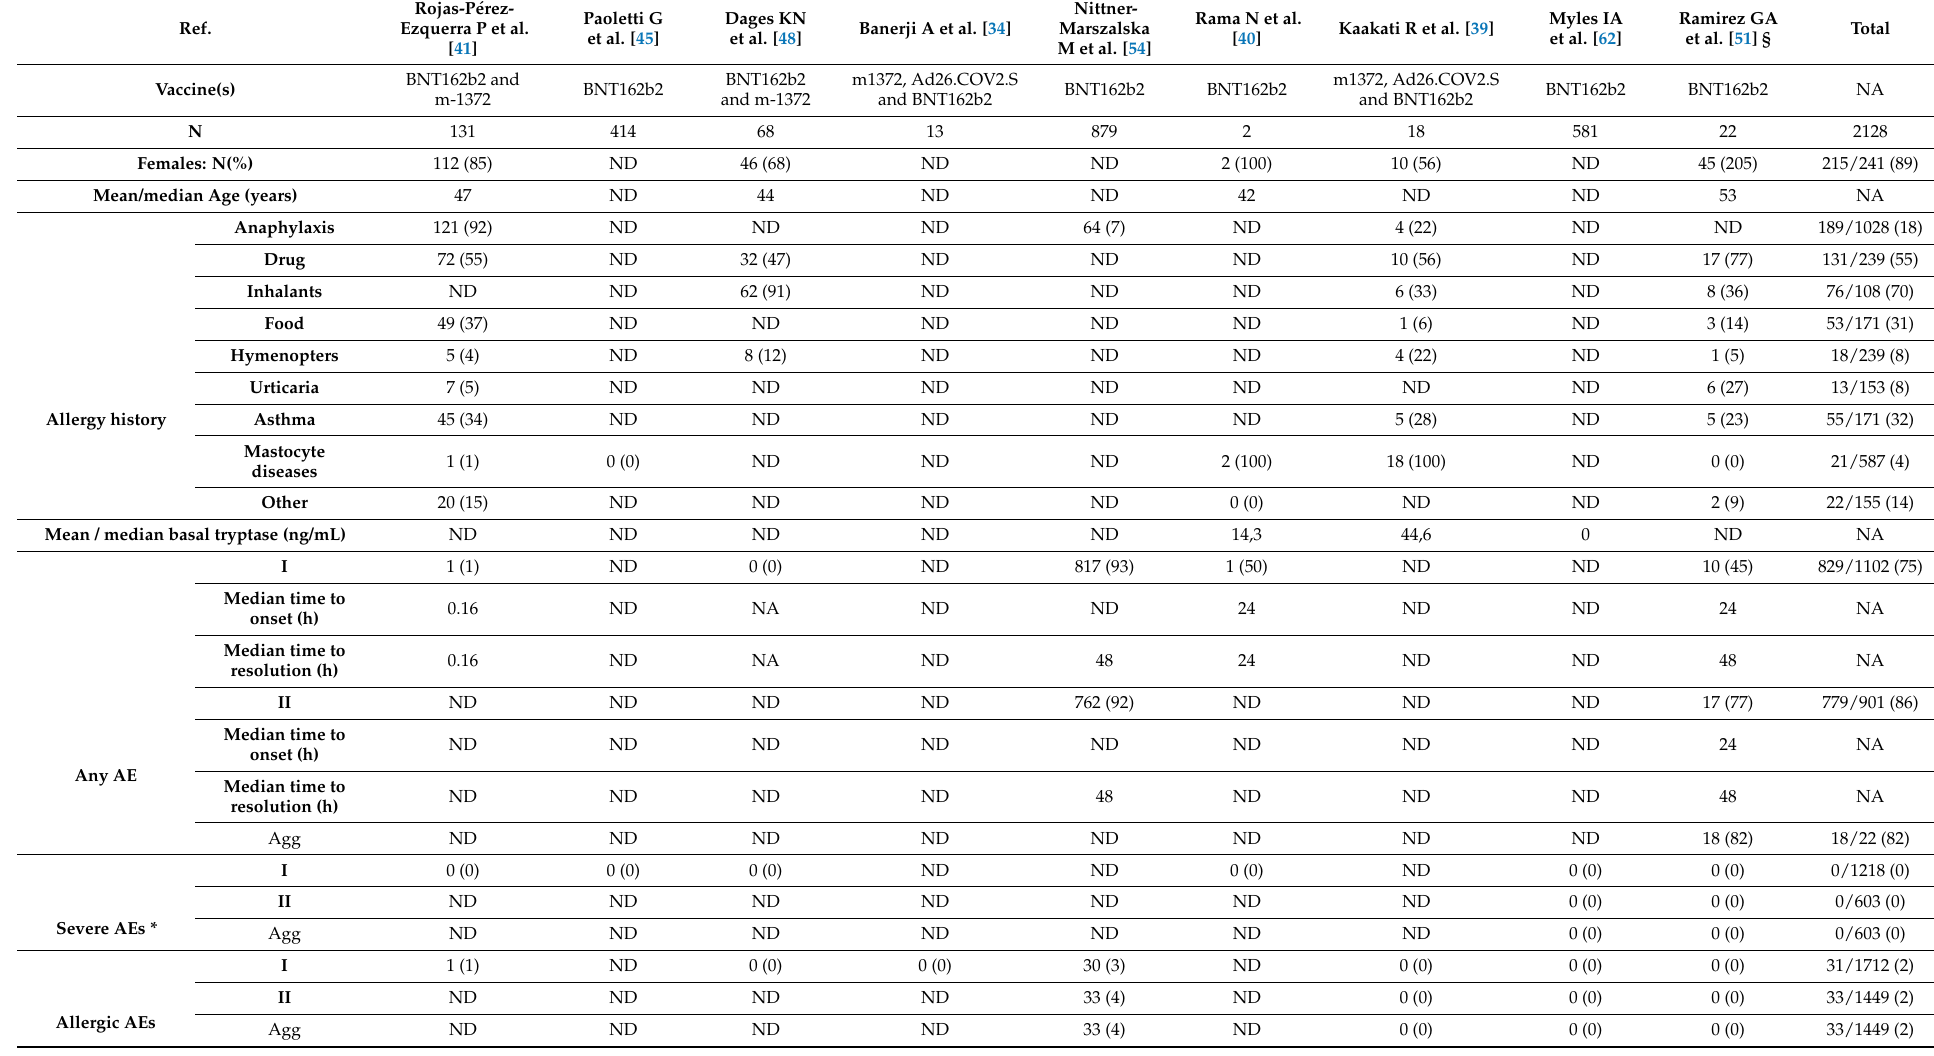
Table 5. Safety of vaccination in patients with a history of